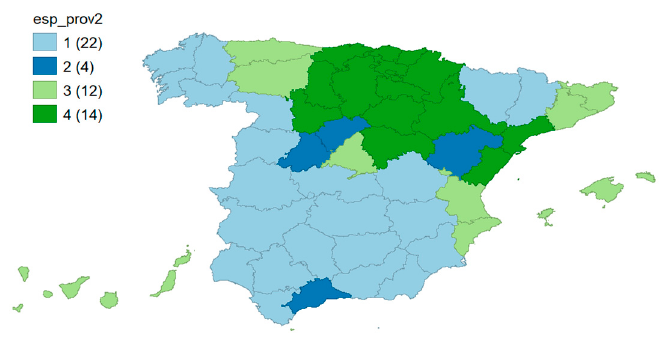
Figure 2. Spatial specialization of activities in Spain by provinces.